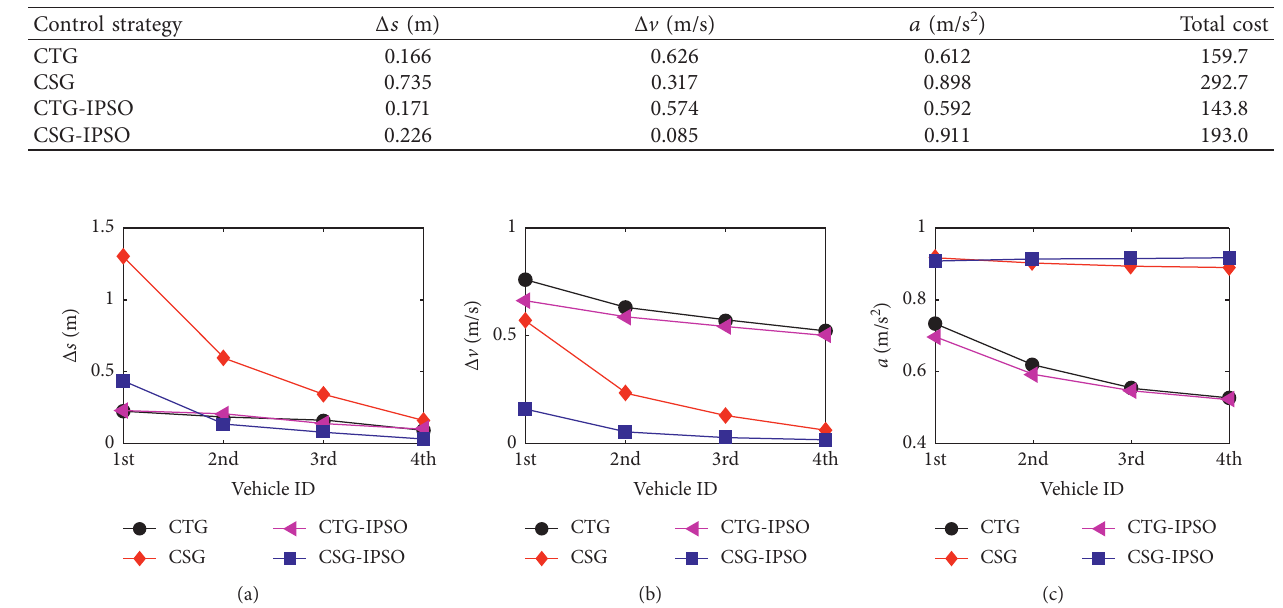
Figure 8: Performance indicator for single CAV: (a) gap error, (b) relative speed, and (c) actual